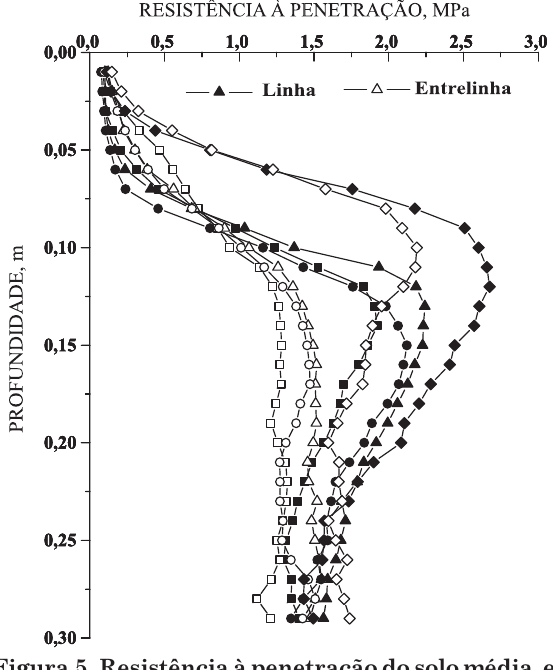
Figura 5. Resistência à penetração do solo média, em profundidade, na linha e entrelinha de plantio. Sem Compactação; Baixa Carga; Alta Carga; Carga do